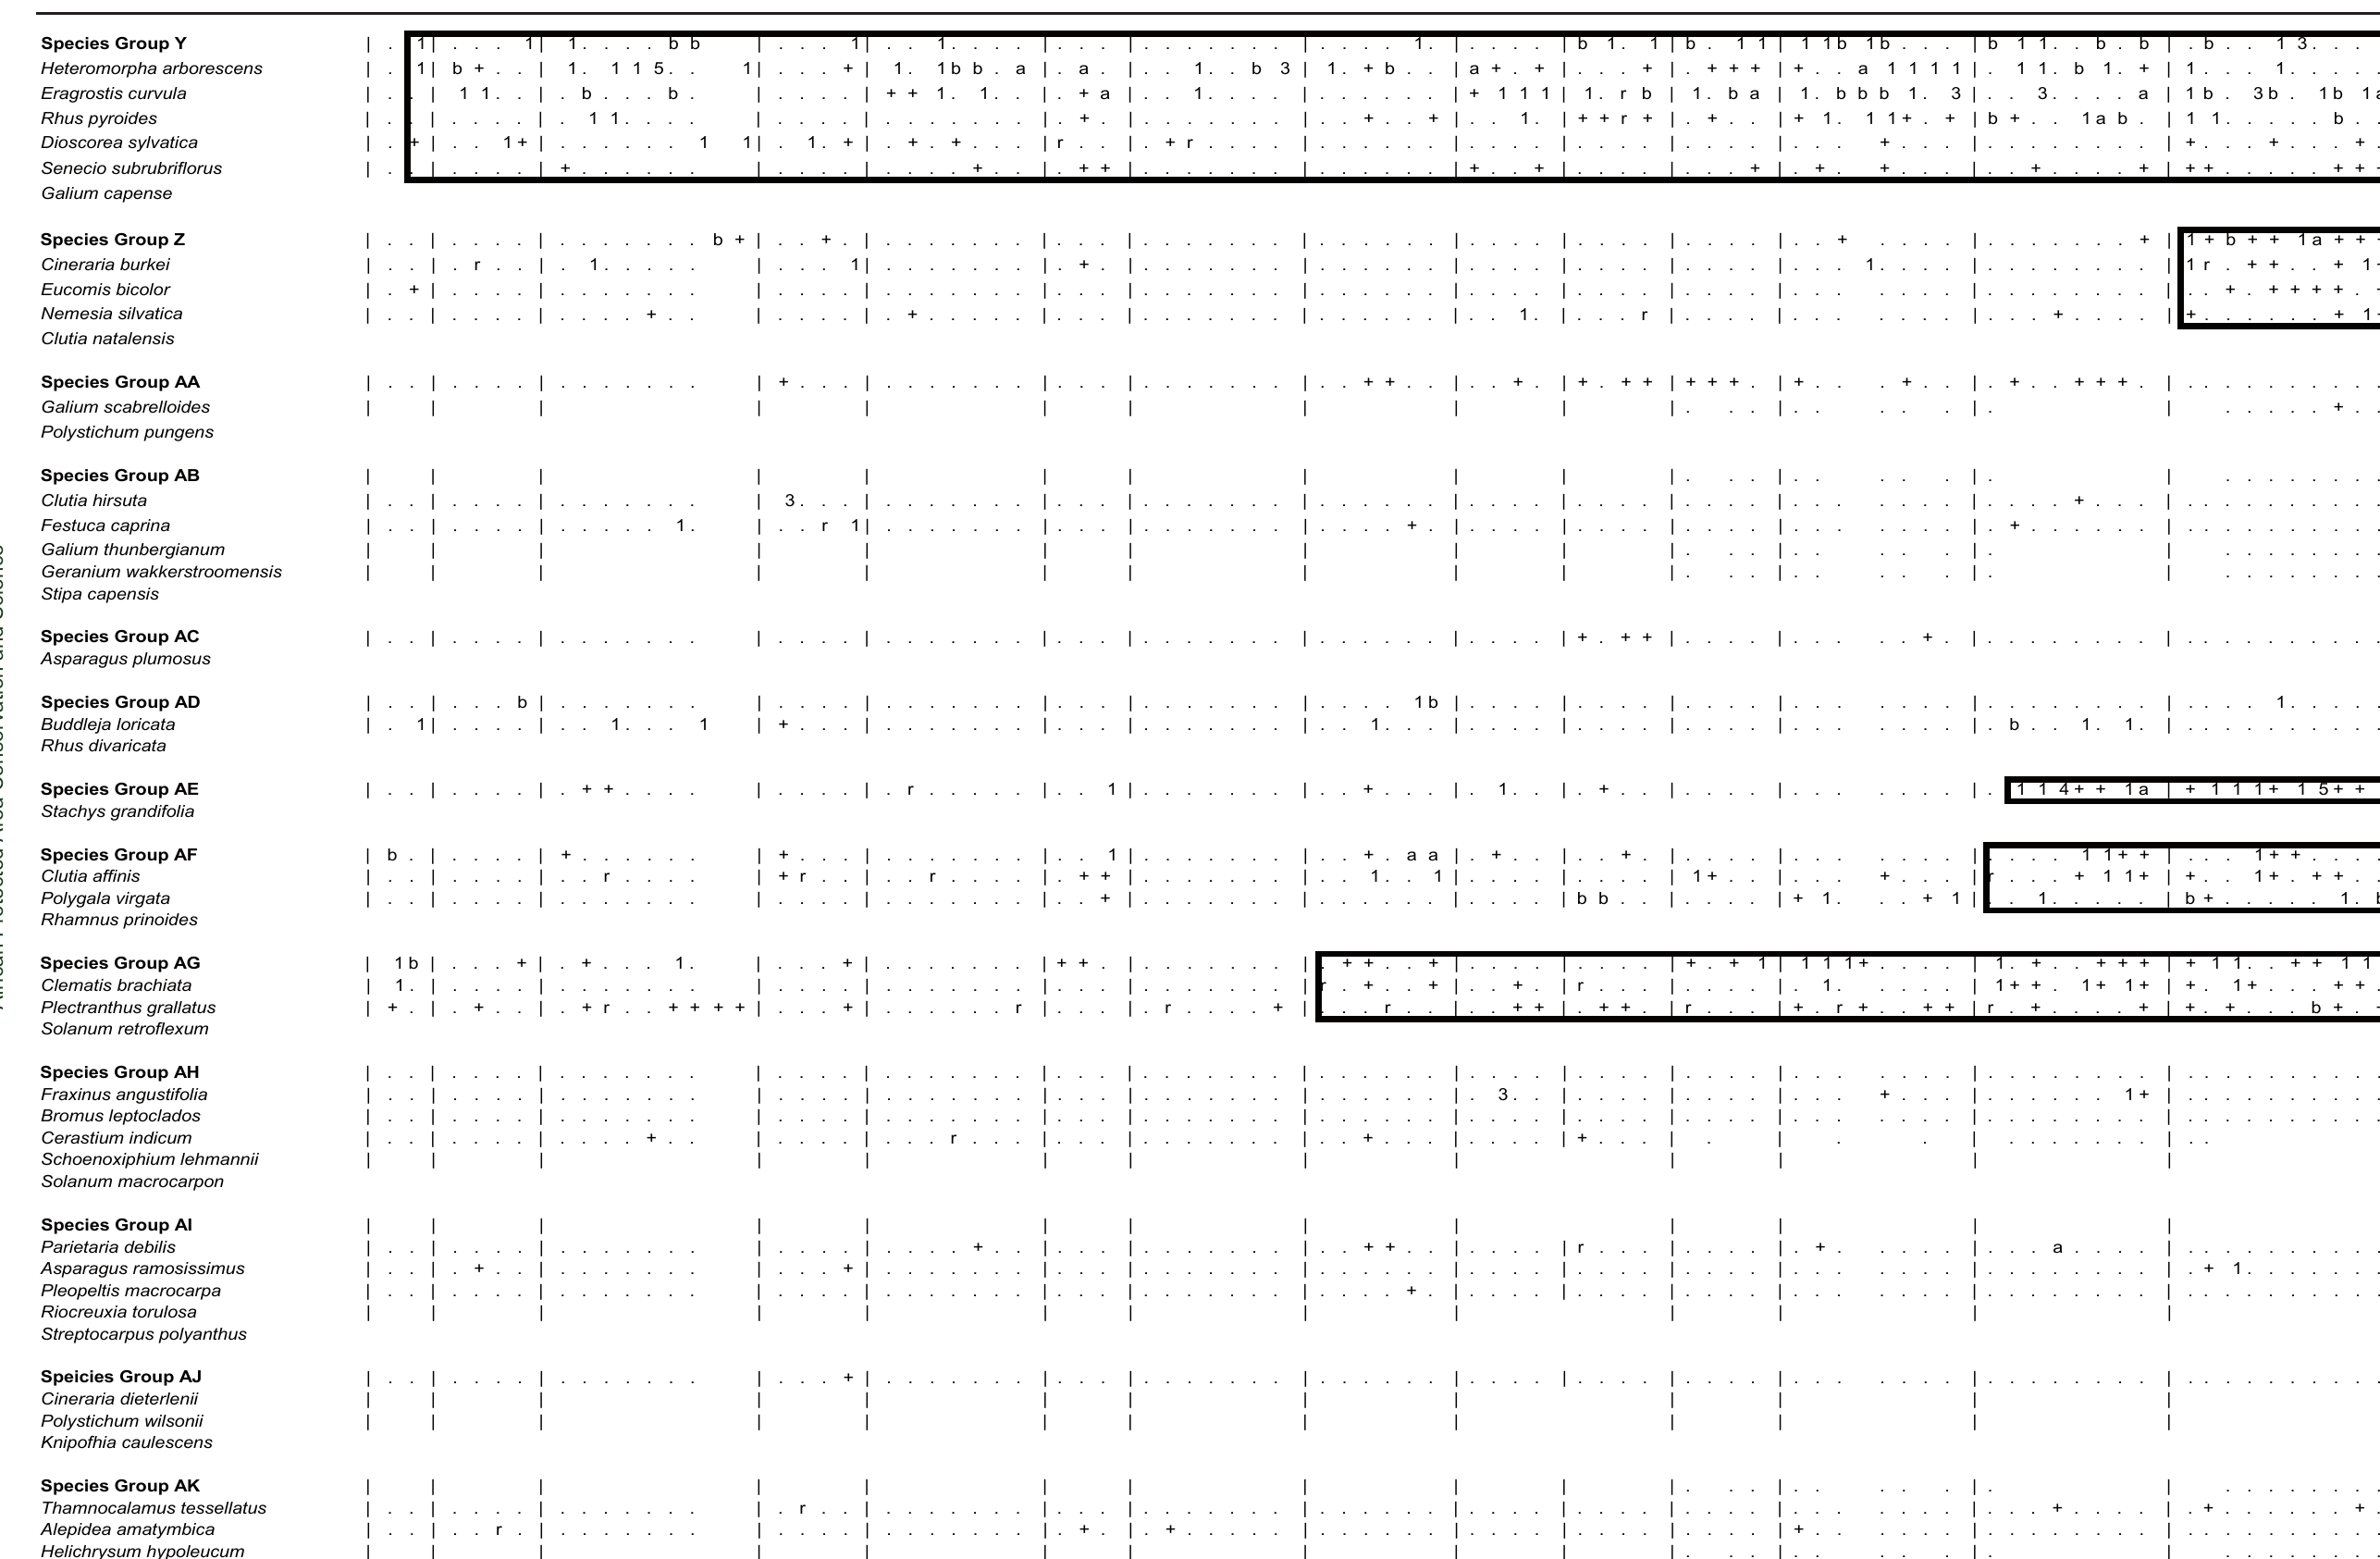
TABLE 1 (Continues.....) Phytosociological table for the shrubland communities of